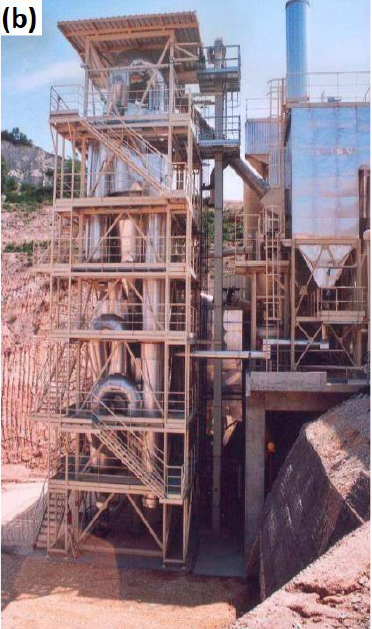
Figure 1. The visual aspect of sediment through treatment stages.